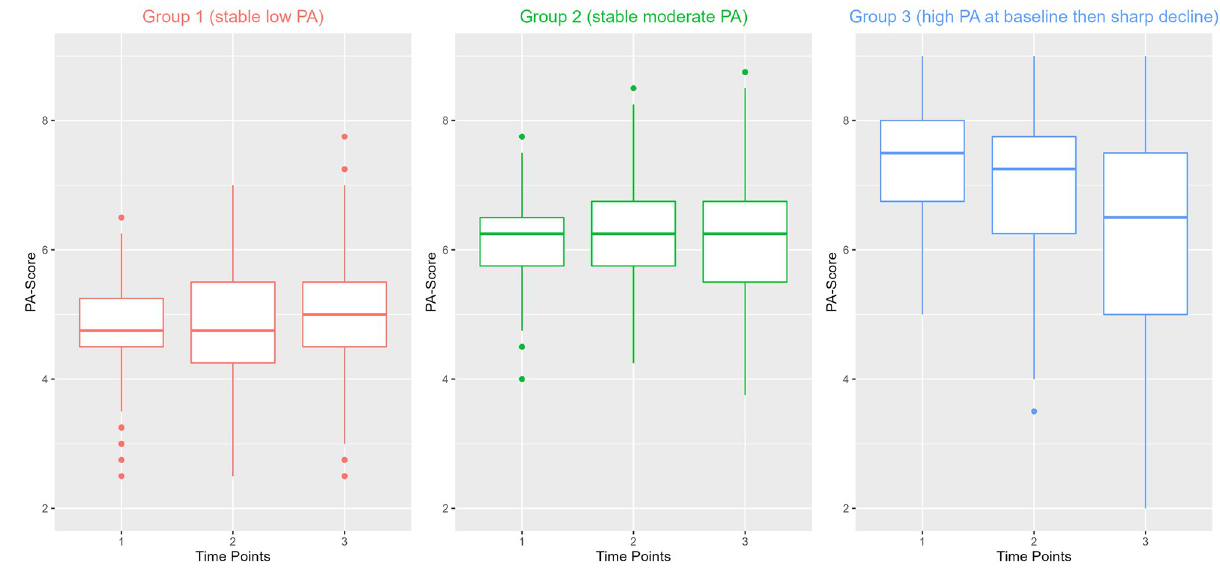
Fig 3. Boxplot showing the mean PA-Score across three time points of the 1041 CARLA participants according to their PA-Trajectories.